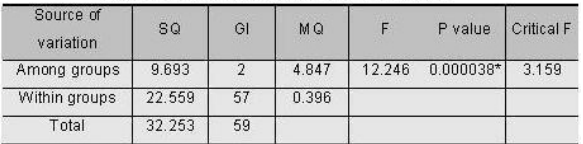
TABLE 2- Randon analysis of variance (ANOVA)